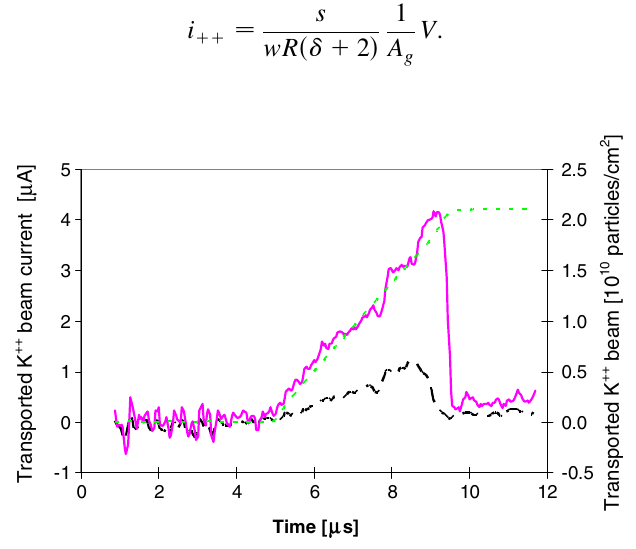
FIG. 12. (Color) This is the total K (cid:1)(cid:1) ion current (solid ma- genta), K (cid:1)(cid:1) current from the entrance slit only (long dashed black), and the integrated number of transported K (cid:1) ions in the analyzer (short dashed green).